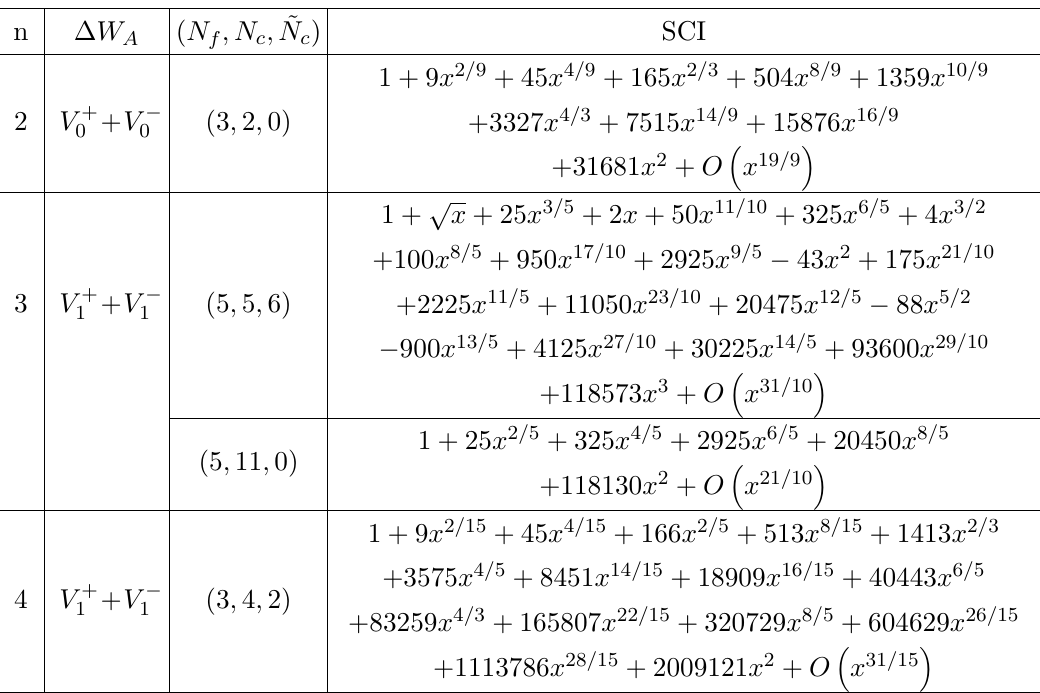
Table 3 . The superconformal index results for the single adjoint theories with ∆ W A = V + . Here we list a specific examples with ( n, α, N V − α (4 , 1 , 3 , 4) , whereas more results are given in appendix B. Note that the index for ( n, α, N (3 , 1 , 5 , 11) is obtained after flipping ˜ QQ and ˜ QXQ , the operators with negative R -charges, by